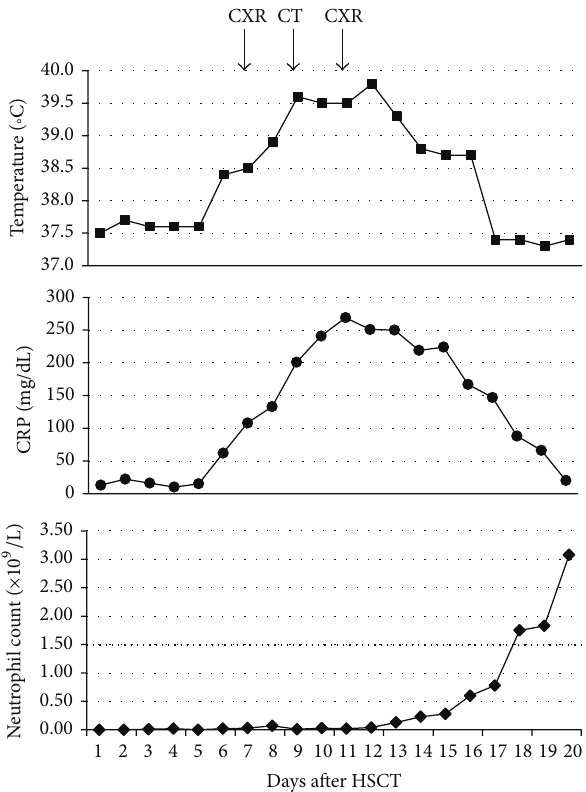
Figure 2: Graphs depicting temperature, CRP, and neutrophil count for 20 days following HSCT. Arrows indicate dates of CT and CXRs. The dotted line on the bottom panel indicates the threshold of neutropenia.